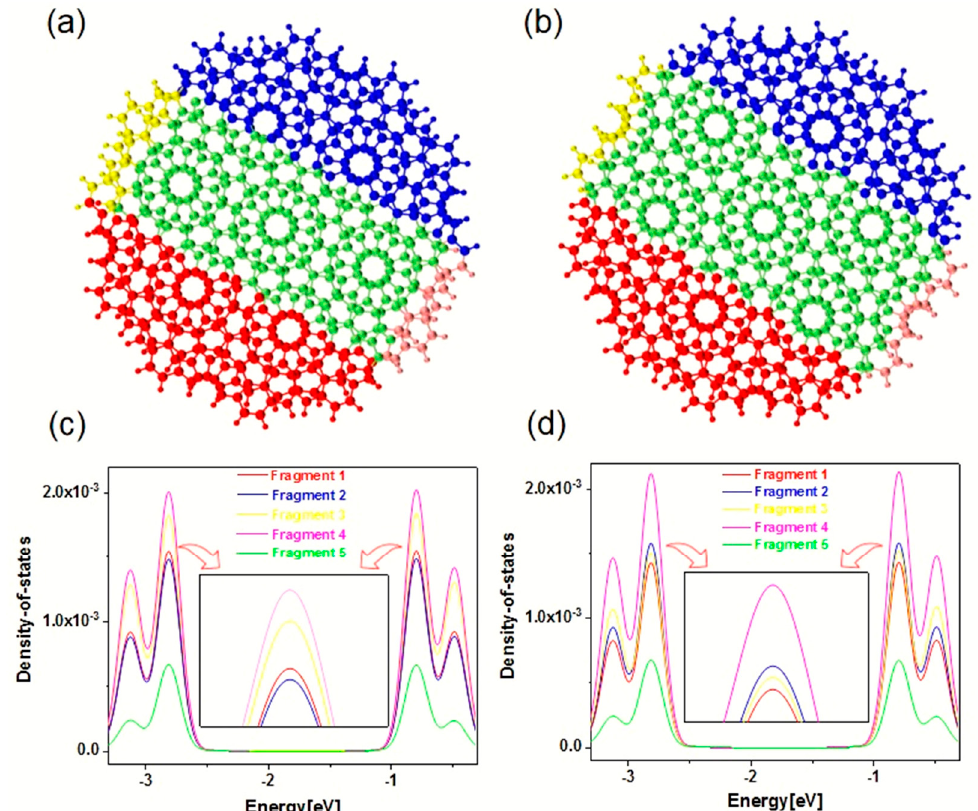
Figure 5. The theoretical calculation of atomic fragment definition of PDOS ( a , b ). The normalized PDOS which is divided by the number of atoms in the fragment integral curve of Z-TwBLG-QDs-27.8° and Z-TwBLG-QDs-32.2° ( c , d ).